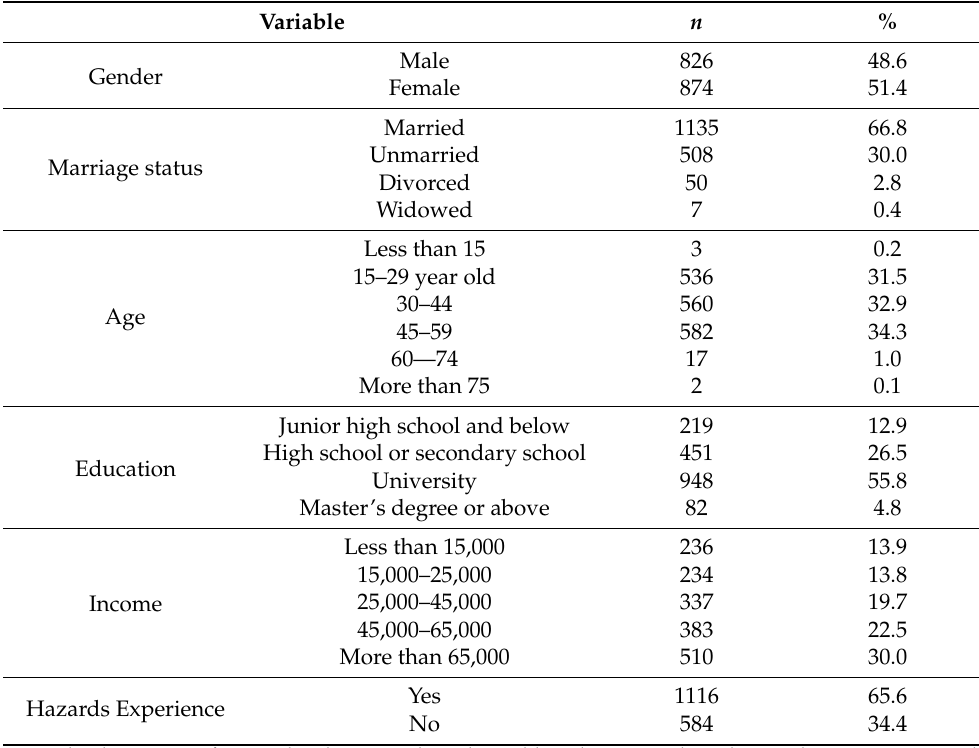
Table 3. Demographic Data of the Participants ( n =